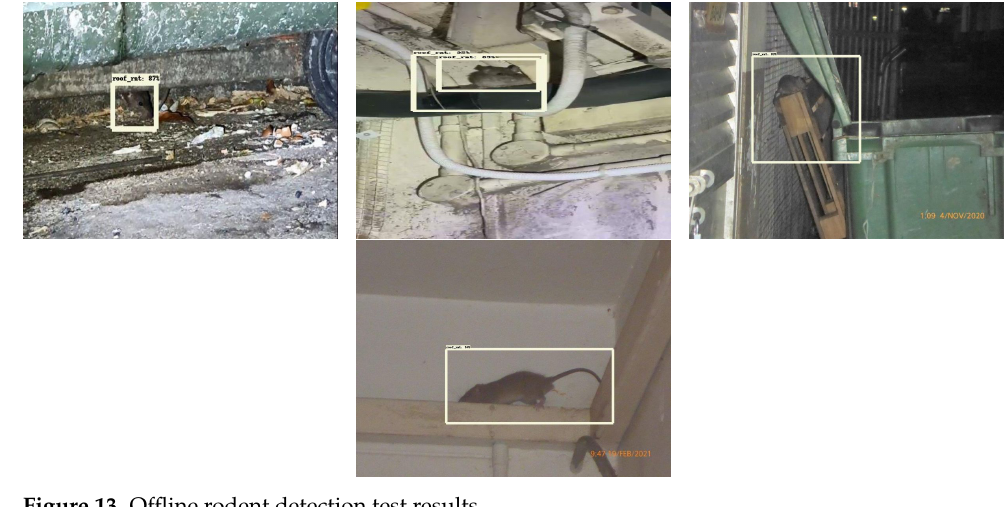
Figure 13. Offline rodent detection test results.